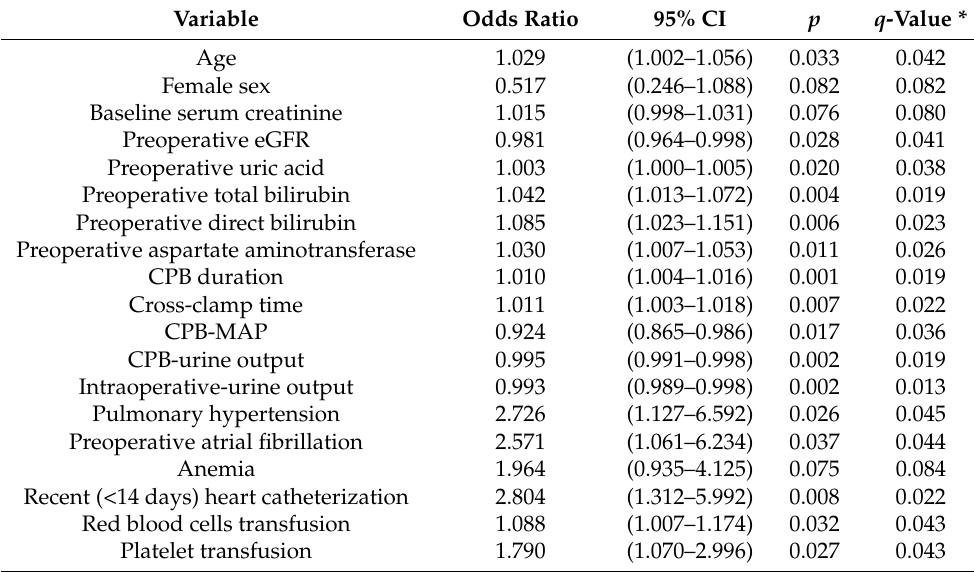
Table 3. Univariate analysis of factors associated with postoperative acute kidney injury. Variable